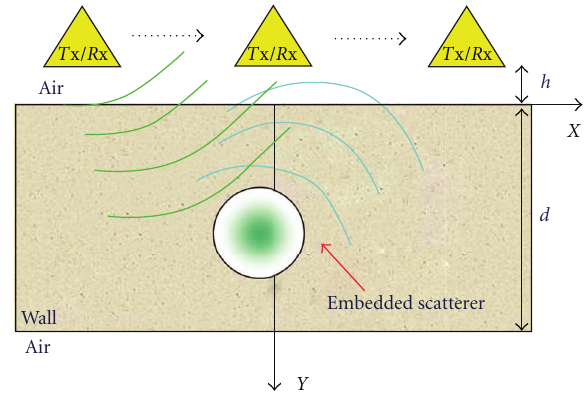
Figure 1: Geometry of the scattering